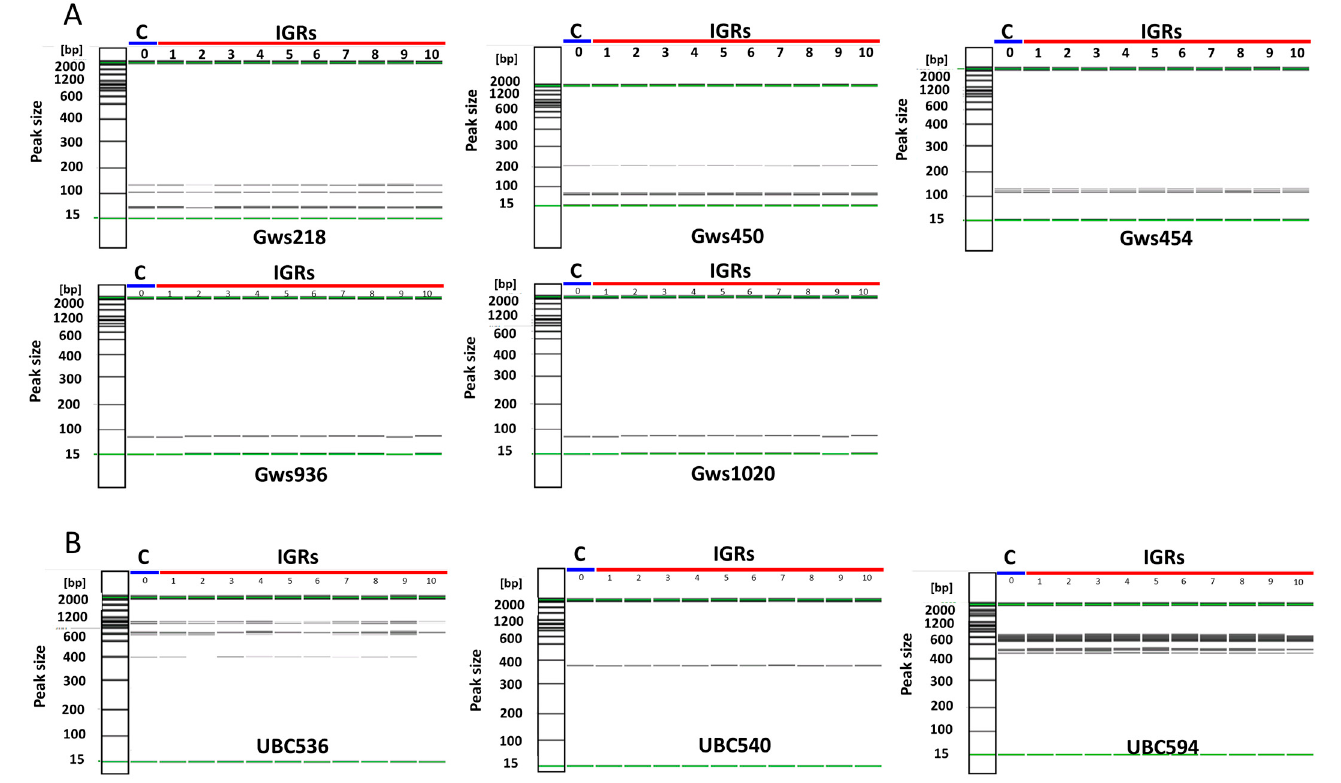
Figure 5. Evaluation of genetic fidelity in the regenerated plants by molecular marker analysis. ( A ) gws218, gws450, gws454, gws936, and gws1020 SSR markers. ( B ) UBC536, UBC540, and UBC594 RAPD markers. Green lines represent alignment markers. C, control; IGRs, in vitro-grown roots; SSR, simple sequence repeat; RAPD, random ampli fi ed polymorphic DNA.